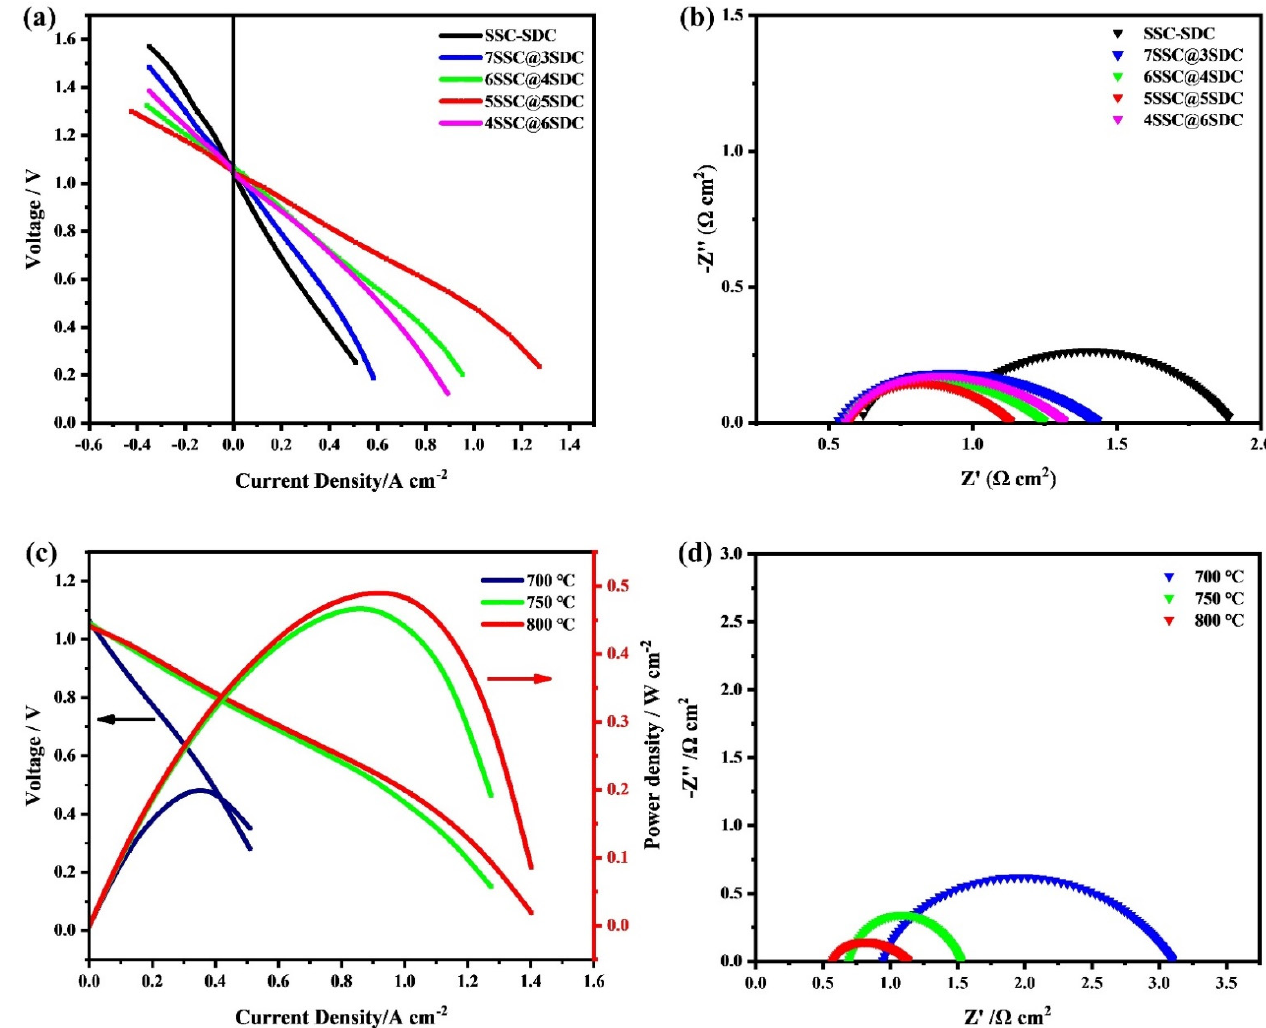
Figure 6. Electrochemical performances of RSOC with the SSC-SDC and SSC@SDC oxygen elec- trodes. ( a ) I-V ( a , b ) EIS curves of RSOCs with SSC-SDC, 7SSC@3SDC, 5SSC@5SDC, and 4SSC@6SDC in fuel cell and electrolysis modes at 800 °C. ( c ) I-V curves and ( d ) EIS curves of RSOCs with 5SSC@5SDC in fuel cell model at 700, 750, and 800 °C. Table 3. Electrochemical performance of the composite oxygen electrodes SSC-SDC, 7SSC@3SDC,